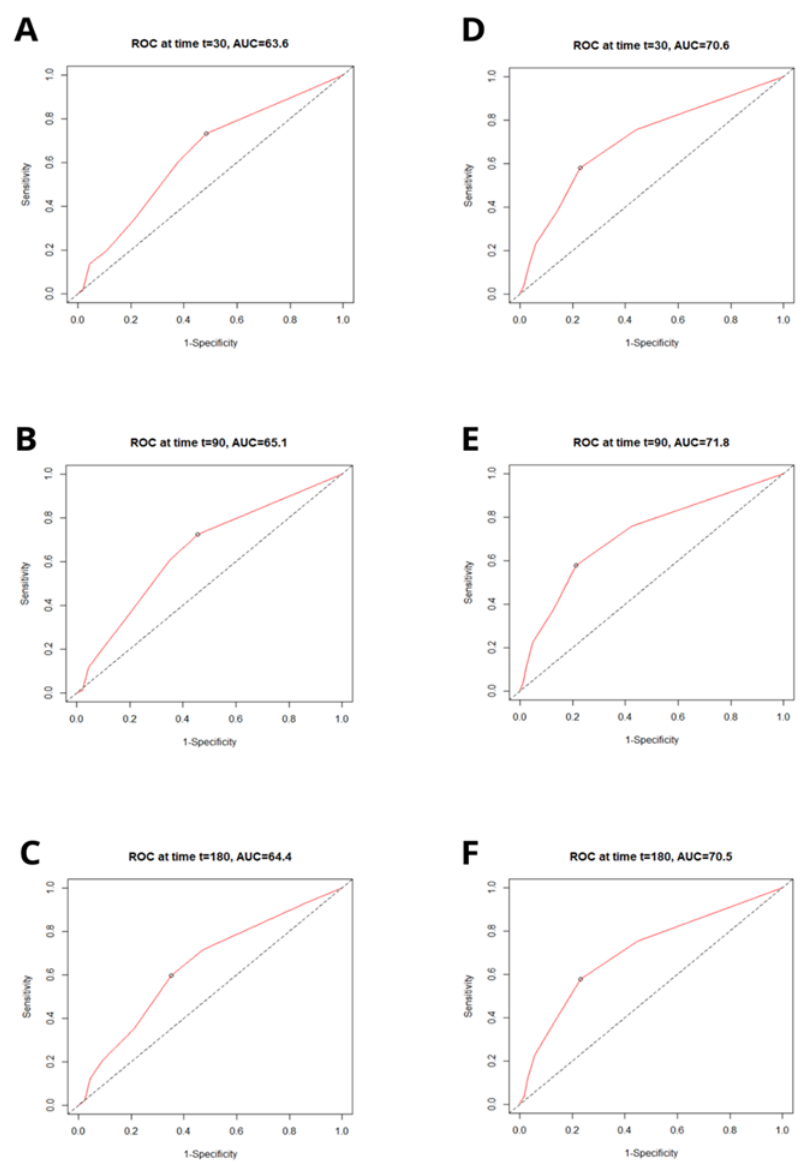
Figure 1. Receiver operating characteristic (ROC) curves for the C 2 HEST score in predicting total mortality in the diabetic ( A – C ) and non-diabetic ( D – F ) cohorts at 3 time points following the positive RT-PCR test (t = 30 days; t = 90 days; t = 180 days). AUC—area under curve.